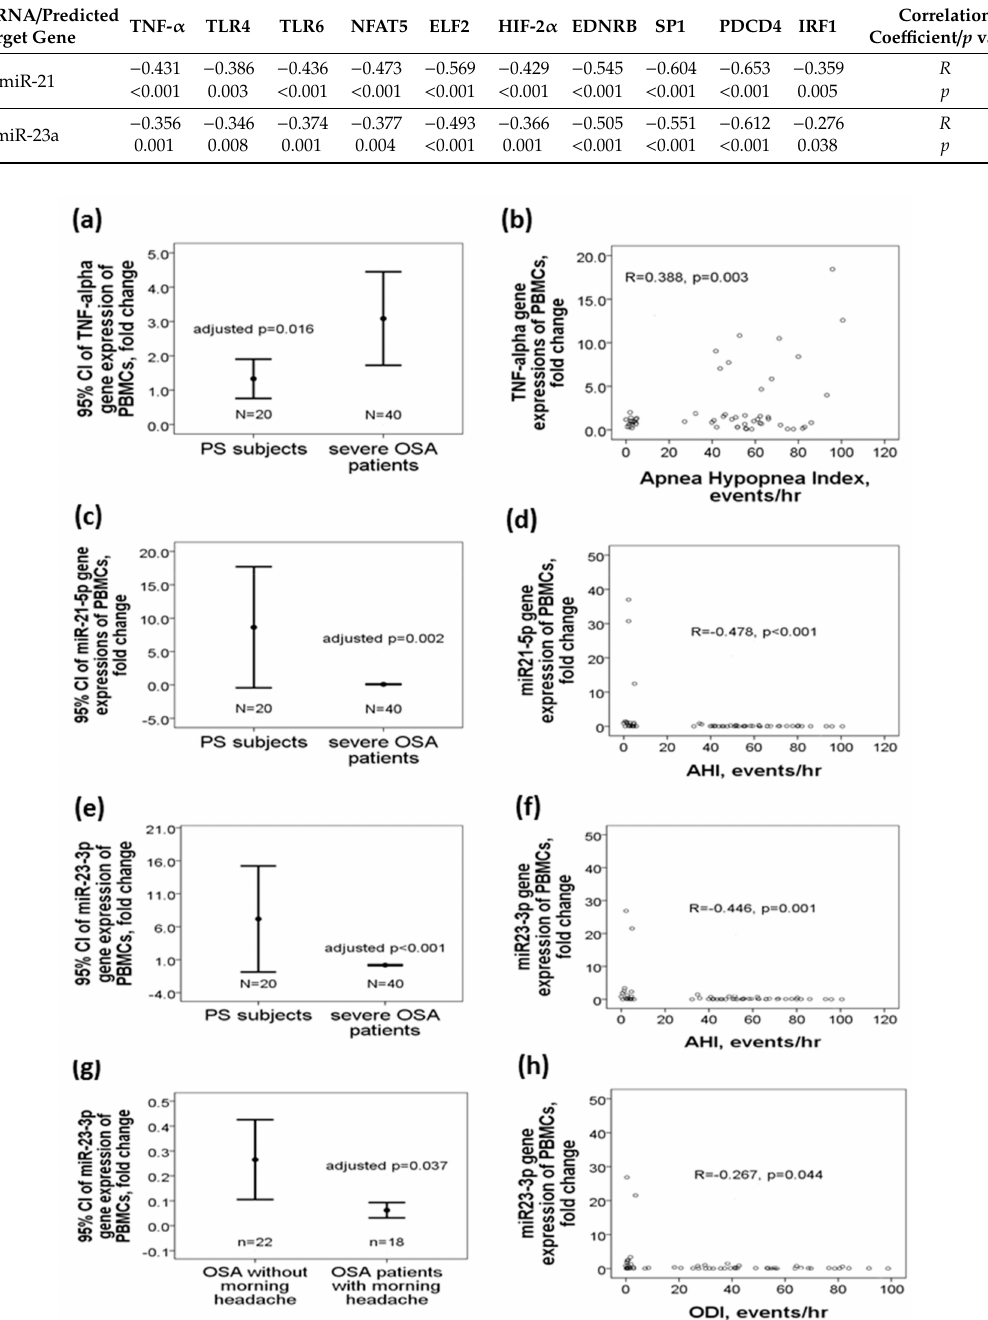
Figure 1. Upregulations of miR-21-5p / miR-23a-3p and downregulation of TNF- α in patients with treatment-naive obstructive sleep apnea. TNF- α gene expression was ( a ) increased in OSA patients, and ( b ) positively correlated with apnea hyponea index. miR-21-5p gene expression was ( c ) decreased in OSA patients, and ( d ) negatively correlated with apnea hypopnea index. miR-23a-3p gene expression was ( e ) decreased in OSA patients, negatively correlated with ( f ) apnea hypopnea index / ( h ) oxygen desaturation index, and ( g ) further decreased in those with morning